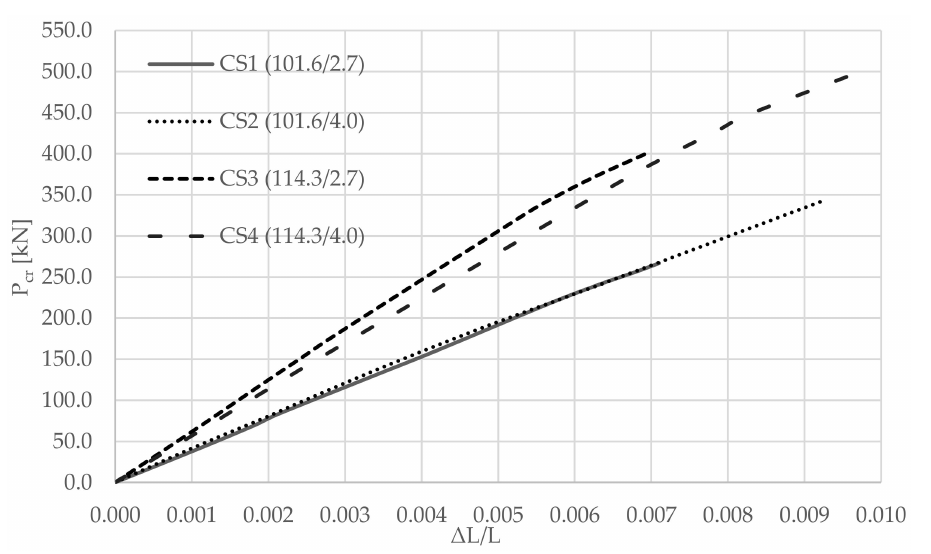
Figure 5. P cr - ∆ L/L relationship for specimens